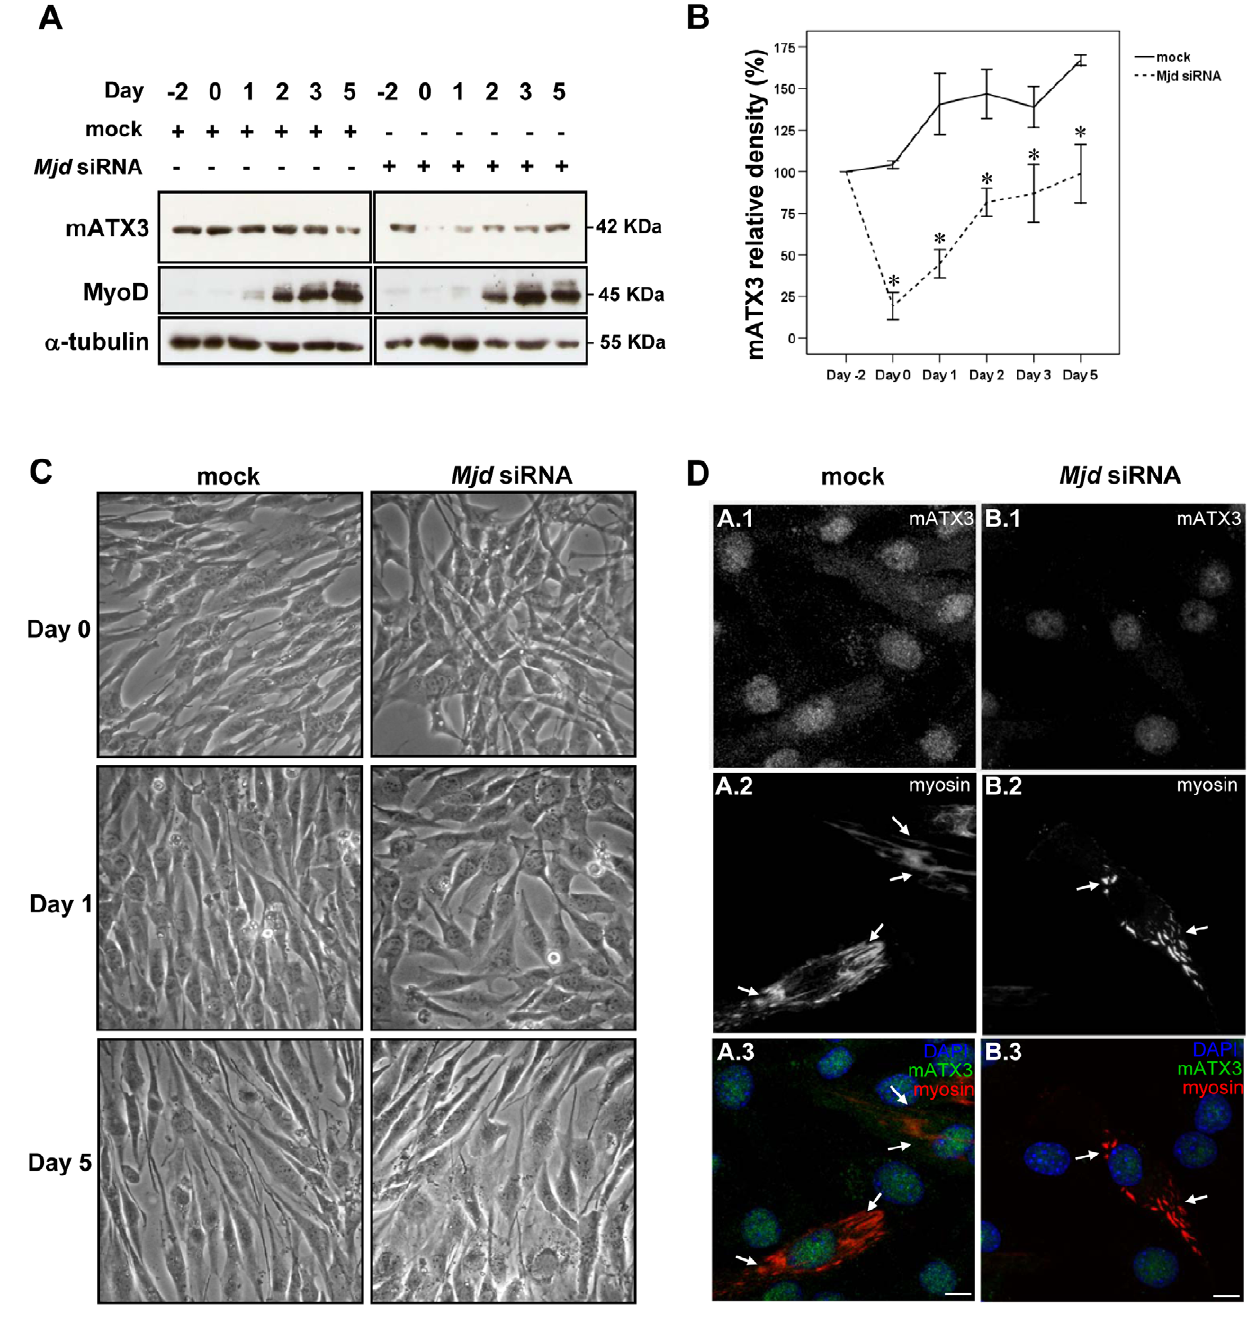
Figure 2. Expression profile of mATX3 during C2C12 differentiation and phenotype of mATX3-depleted cells by Mjd siRNA transfection. Cells were transfected at Day -2 and maintained in growth medium (GM) for 48 hrs (Day 0), then the medium was replaced by differentiation medium (DM) and changed every day until Day 5. (A) Whole cell extracts of undifferentiated (Day -2 and Day 0) and differentiated cells (Day 1 to Day 5) were analyzed for mATX3, MyoD and a -tubulin in mock and Mjd siRNA transfected cells. The amounts of ataxin-3 and MyoD were determined by immunoblotting. The myogenic factor MyoD is not a target of mATX3. Both mock and Mjd siRNA-transfected cells show that this MRF is upregulated upon differentiation. (B) Relative band density of mATX3 in each day (comparing with Day -2) shows that the Mjd siRNA has maximum efficiency two days after transfection (Day 0). The results were normalized for a -tubulin and correspond to the average of three independent transfections 6 SEM (error bars). * statistical significance p , 0.05 using Student t-test. (C) Phenotype of the Mjd siRNA C2C12 cells during differentiation. At Day 0 and Day 1, when mATX3 depletion is higher, the Mjd siRNA cells show extensive cell-cell misalignment, and rounder shape compared to mock-transfected cells. Although the mATX3 levels were partially restored at Day 5, the knocked-down cells still present some misalignment. (D) The maximum projection of confocal optical z-series images of mATX3 and myosin double-stained cells at differentiation Day 5. In contrast to mock control cells that show a well organized myosin cytoskeleton (arrows), mATX3-depleted cells show an abnormally fragmented myosin staining with a very short filament pattern. (1) mATX3 staining, (2) myosin (MHC) labeling, (3) triple overlay of mATX3, myogenic marker, and DAPI (DNA marker). Scale bars represent 10 m m.